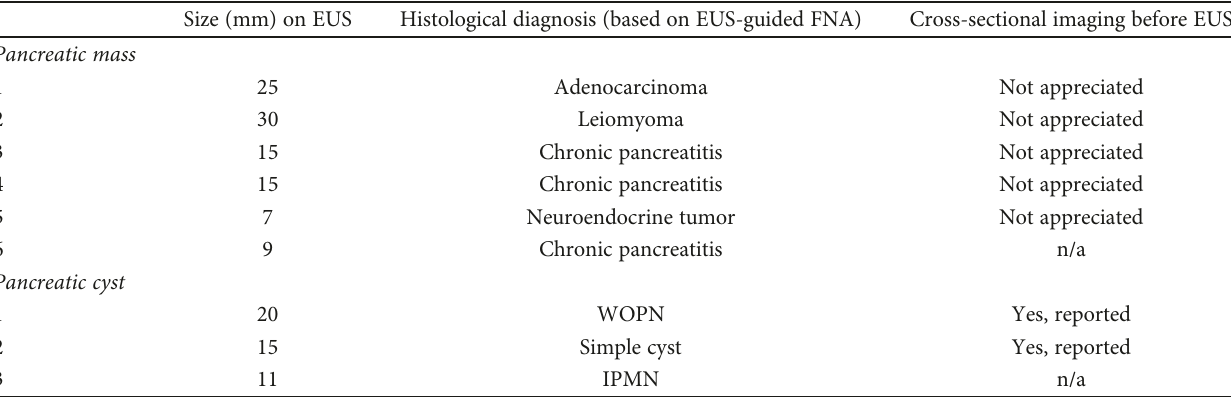
Table 4: Patients with pancreatic mass or cystic lesion on endoscopic ultrasound. Findings on EUS, histology, and cross-sectional imaging. Size (mm) on